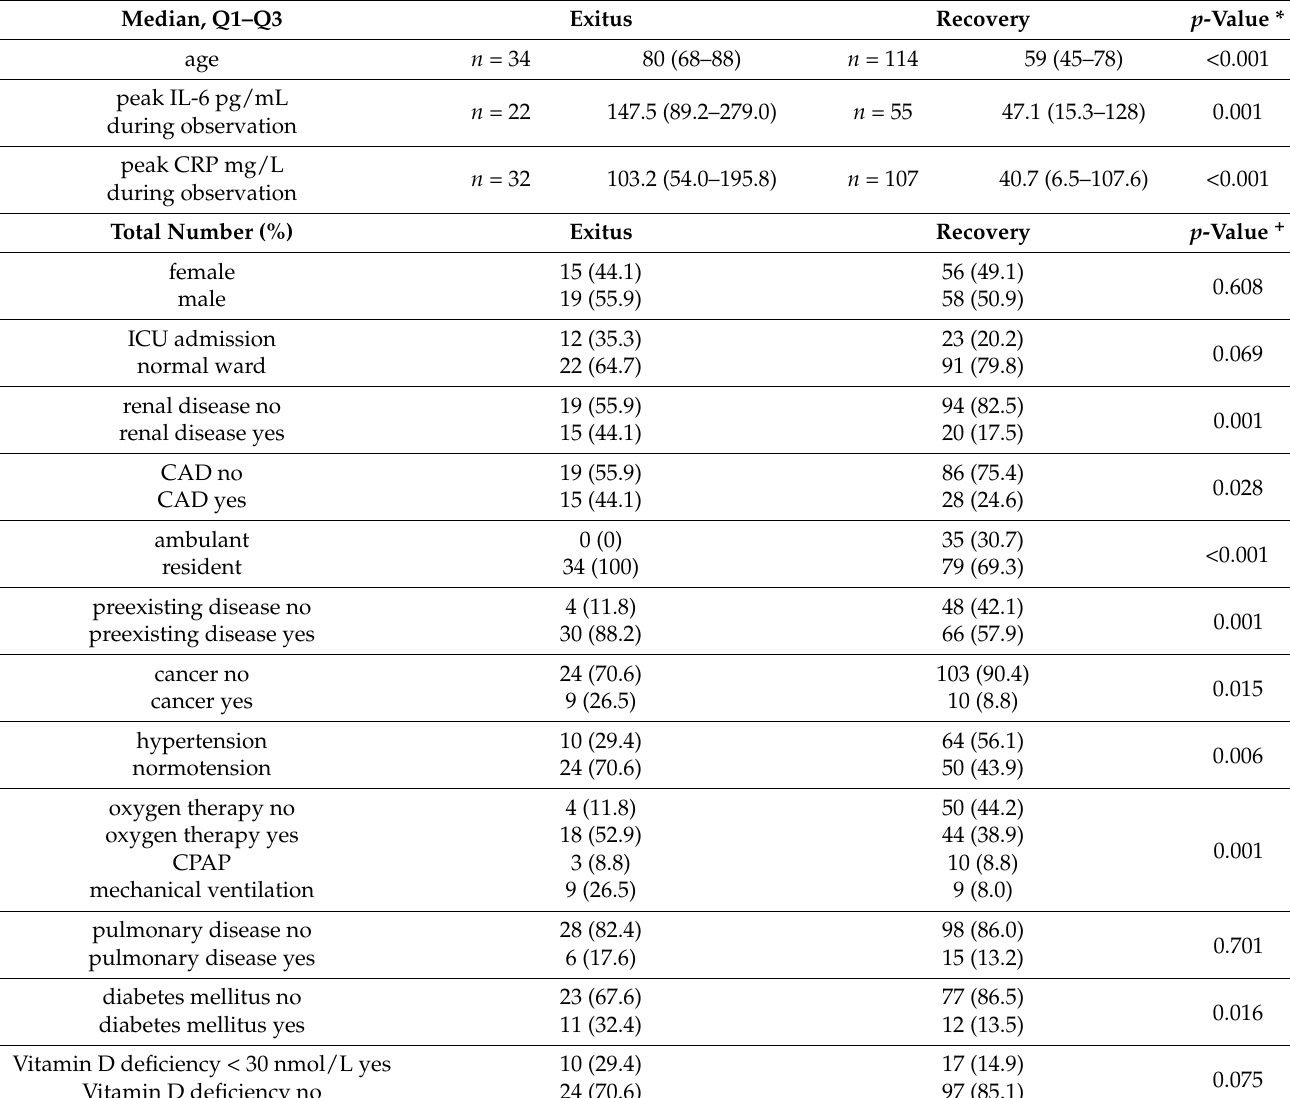
Table 1. Baseline characteristics of COVID-19